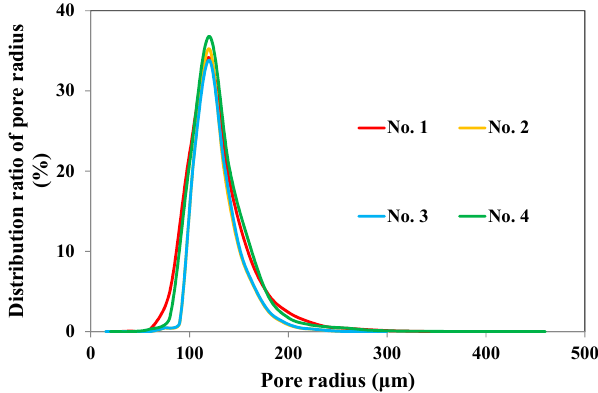
Figure 1. Pore radius distribution of each core.